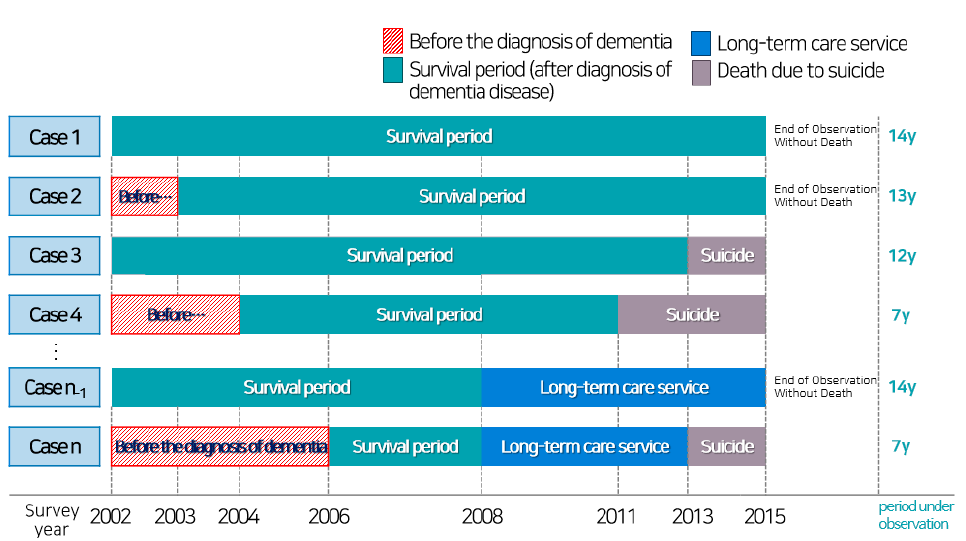
Figure 1. The structure of the study sample.